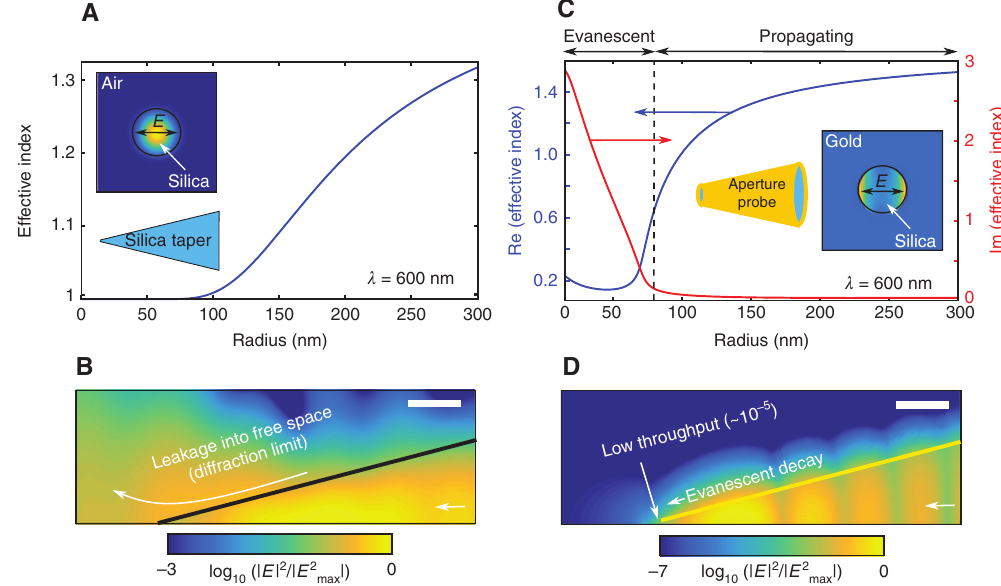
Figure 2: Inherent limits of conventional subwavelength fiber-based nanotips. (A) Calculated effective index of the fundamental linearly polarized mode a silica nanofiber (inset) as a function of its local radius. For small radii, light leaks into free space (effective index = 1) and cannot be confined. (B) Finite element calculations of the intensity (log scale) for a mode propagating toward the apex of a tapered silica nanotip. Black line: edge of the taper. (C) Calculated real (blue) and imaginary (red) parts of the effective index of the fundamental linearly polarized mode a silica nanofiber that is embedded in gold (inset) as a function of its local radius, corresponding to a typical aperture probe. For small radii, the mode cuts off and becomes evanescent, leading to low through- put (1.3 × 10 −5 ) through the aperture (diameter: 10 nm). (D) Finite element calculations of the intensity (log scale) of the mode propagating down a tapered aperture probe. Yellow line: edge of the metal-coated taper. Scale bar (B and D), 200 nm. The radius of the fiber at the tip/ aperture in B or D is 10 nm. All calculations are performed at λ = 600